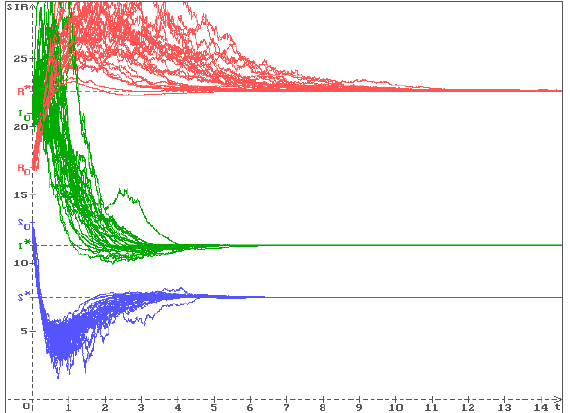
Figure 4. Fifty trajectories of the solution of the system (6) solution: S ( t ) (blue), I ( t ) (green), R ( t ) (red) with the initial values S ( 0 ) = 13, I ( s ) = 21, s ∈ [ − h ,0 ] , R ( 0 ) = 17 in the point V ( δ 1 , δ 2 ) = V ( 2,0.8 ) , δ 3 = 0.7, h =